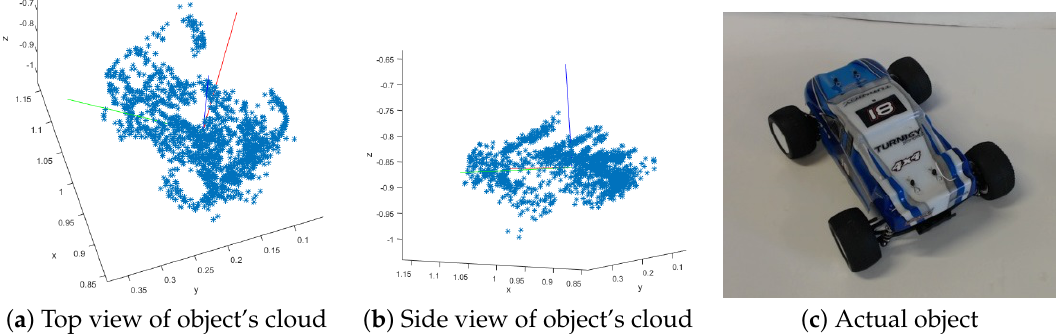
Figure 15. Example of an extracted object. ( a,b ) show the point cloud from different angles; ( c ) is a picture of the actual